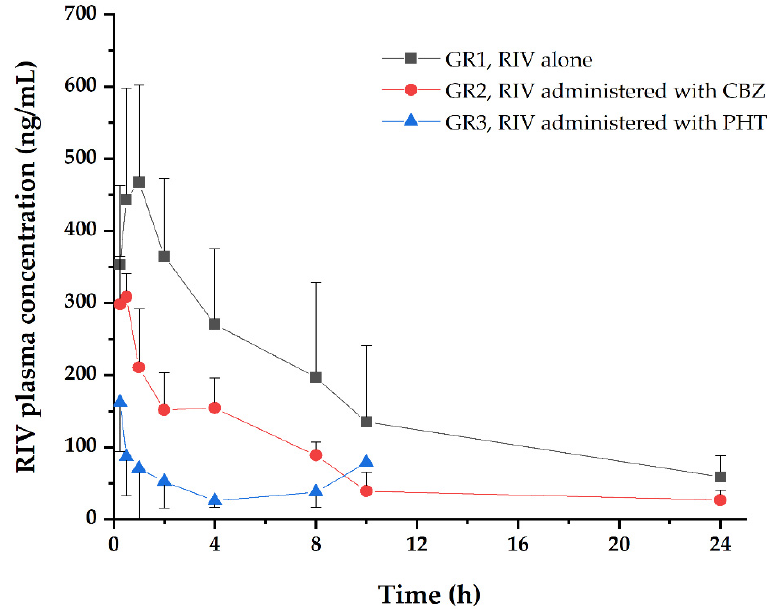
Figure 2. Plasma concentration–time profile of RIV after oral administration of RIV with / without CBZ / PHT pretreatment. Each point represents the mean and standard deviation. Table 1. PK parameters (mean ± standard deviation) of RIV with / without PHT / CBZ pretreatment and result of statistical analysis. GR1, RIV alone ( n = 12); GR2, RIV administered with CBZ ( n = 6); GR3, RIV administered with PHT ( n = 6).